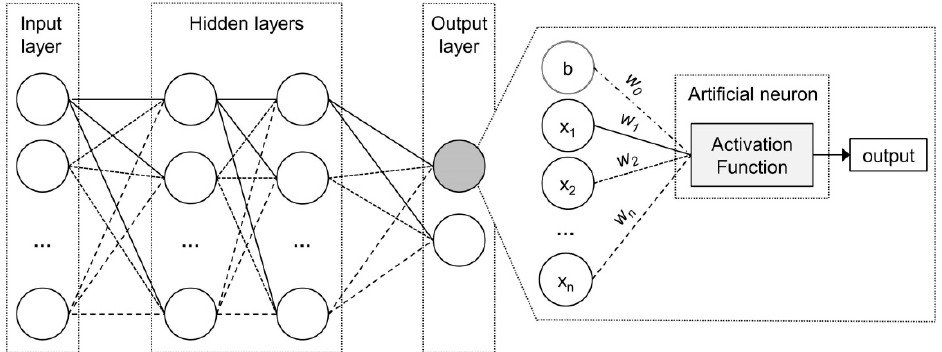
Figure 2. Depiction of a feedforward neural network (NN) with two hidden layers ( left ), showing an artificial neuron in detail ( right ). Each input x i has an associated weight w i (the bias term b is associated with weight w 0 ). The activation value of the neuron is given by ∑ 𝑤 (cid:3036) 𝑥 (cid:3036)(cid:3041) (cid:3036)(cid:2880)(cid:2869) + 𝑤 (cid:2868) 𝑏 which is then transformed via a nonlinear activation function (e.g., a rectified linear unit or relu) in order to derive the final output value.